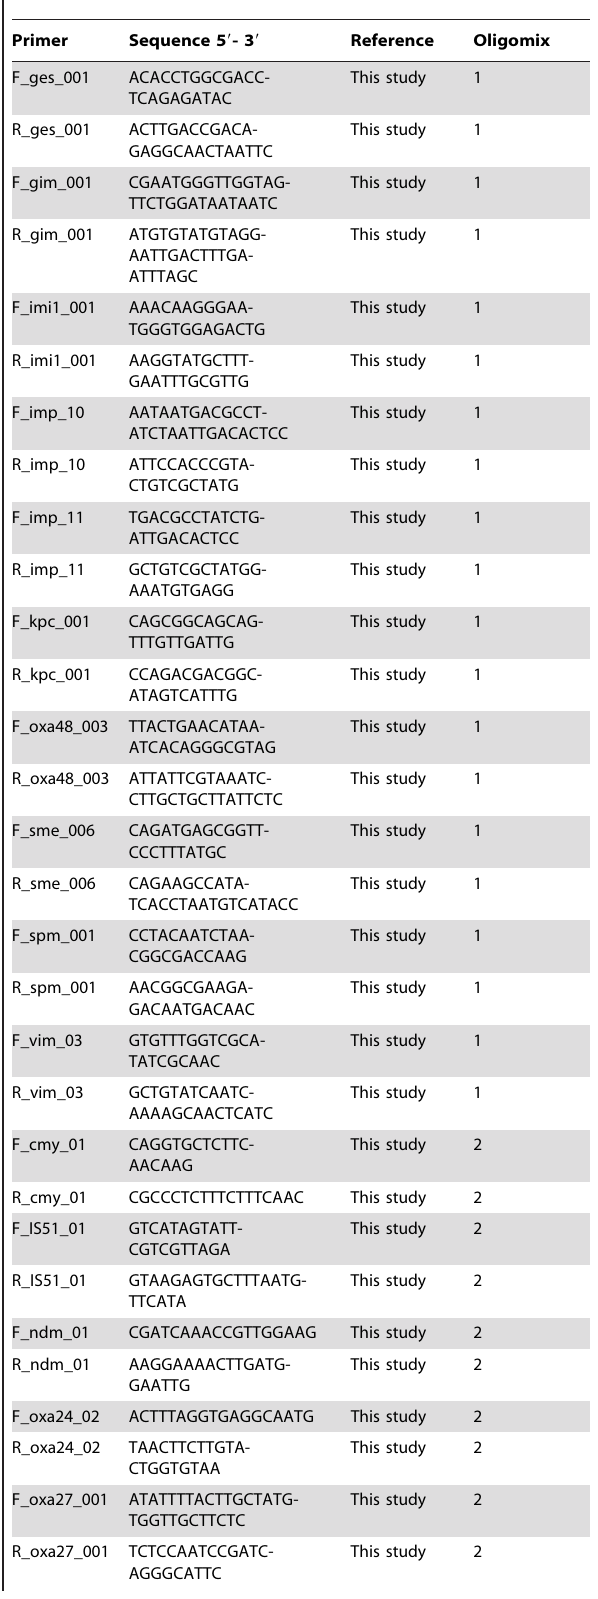
Table 2. Primers used for amplification of resistance genes by polymerase chain reaction (PCR).